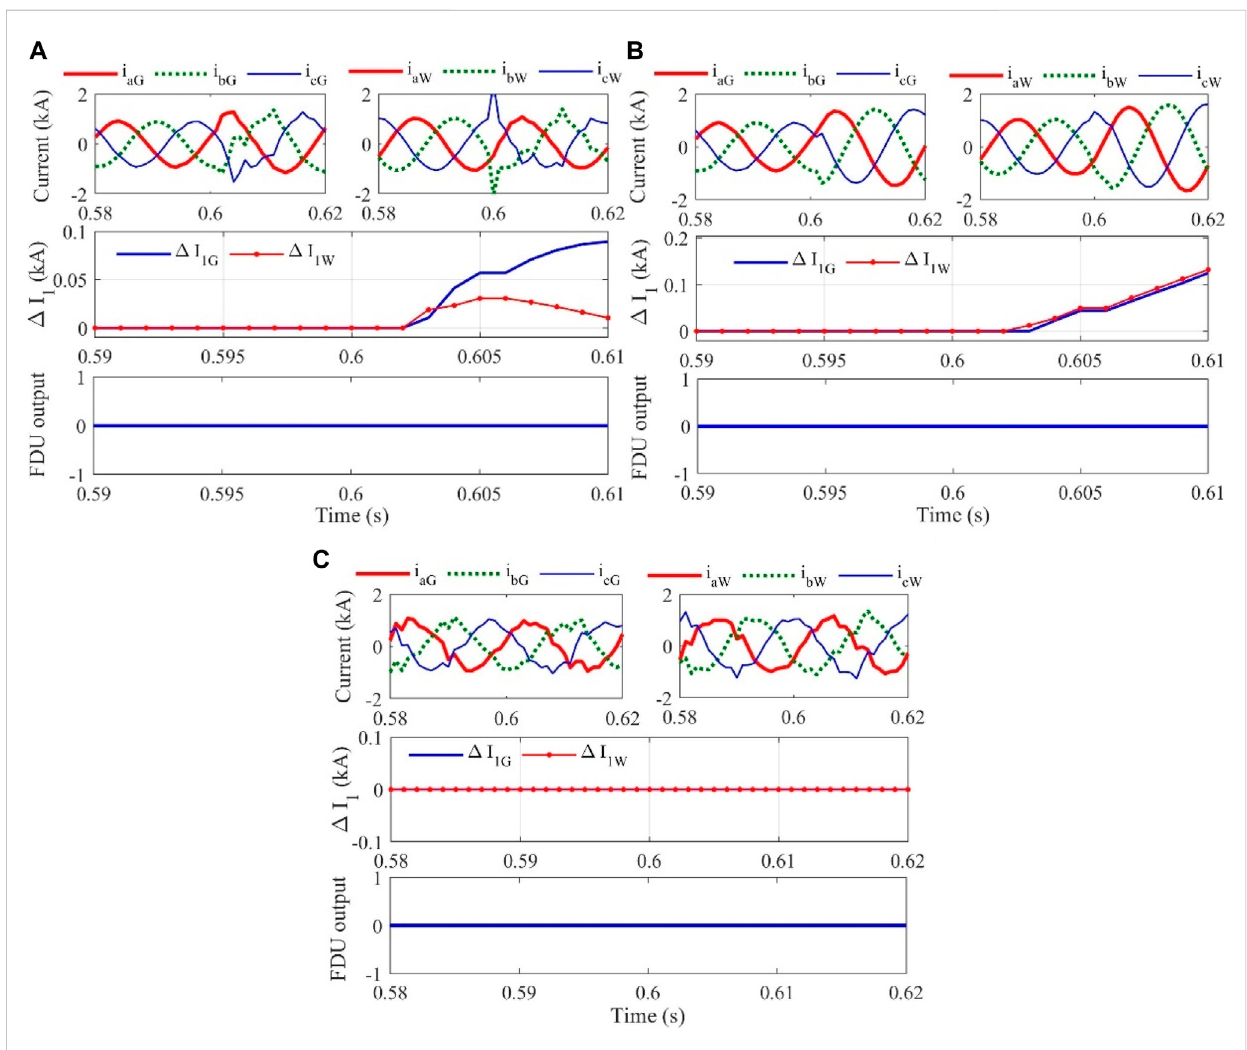
FIGURE 10 Results during switching transients: (A) capacitor switching, (B) load switching, and (C) presence of noise in the current